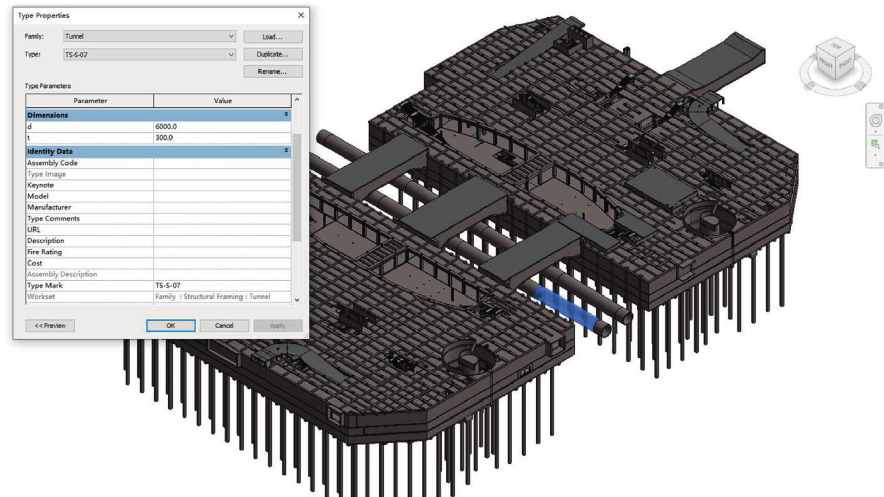
Figure 11: Revit component type parameter setting.